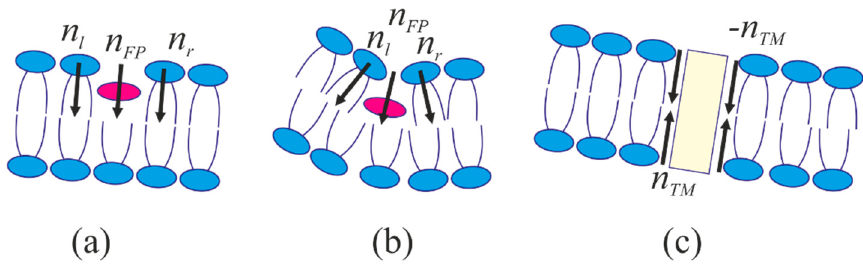
Figure 6. Schematic representation of fusion peptide domains (shown as magenta ellipse) in a bilayer. ( a ) intermediate incorporation depth; ( b ) deep incorporation; ( c ) transmembrane domain (shown as yellow rectangle). Black arrows show the boundary director orientations.